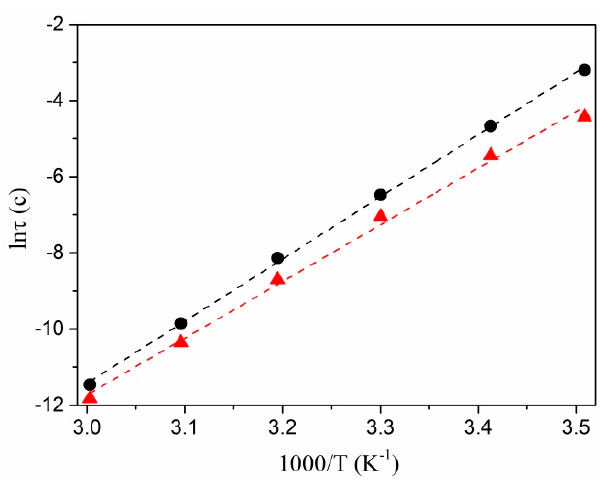
Figure 5. Logarithm of relaxation time vs. 1/ T for Ag/PAN nanocomposites made at 20 ( ● ) and 30 ( ▲ ) wt.% of AgNO 3 .